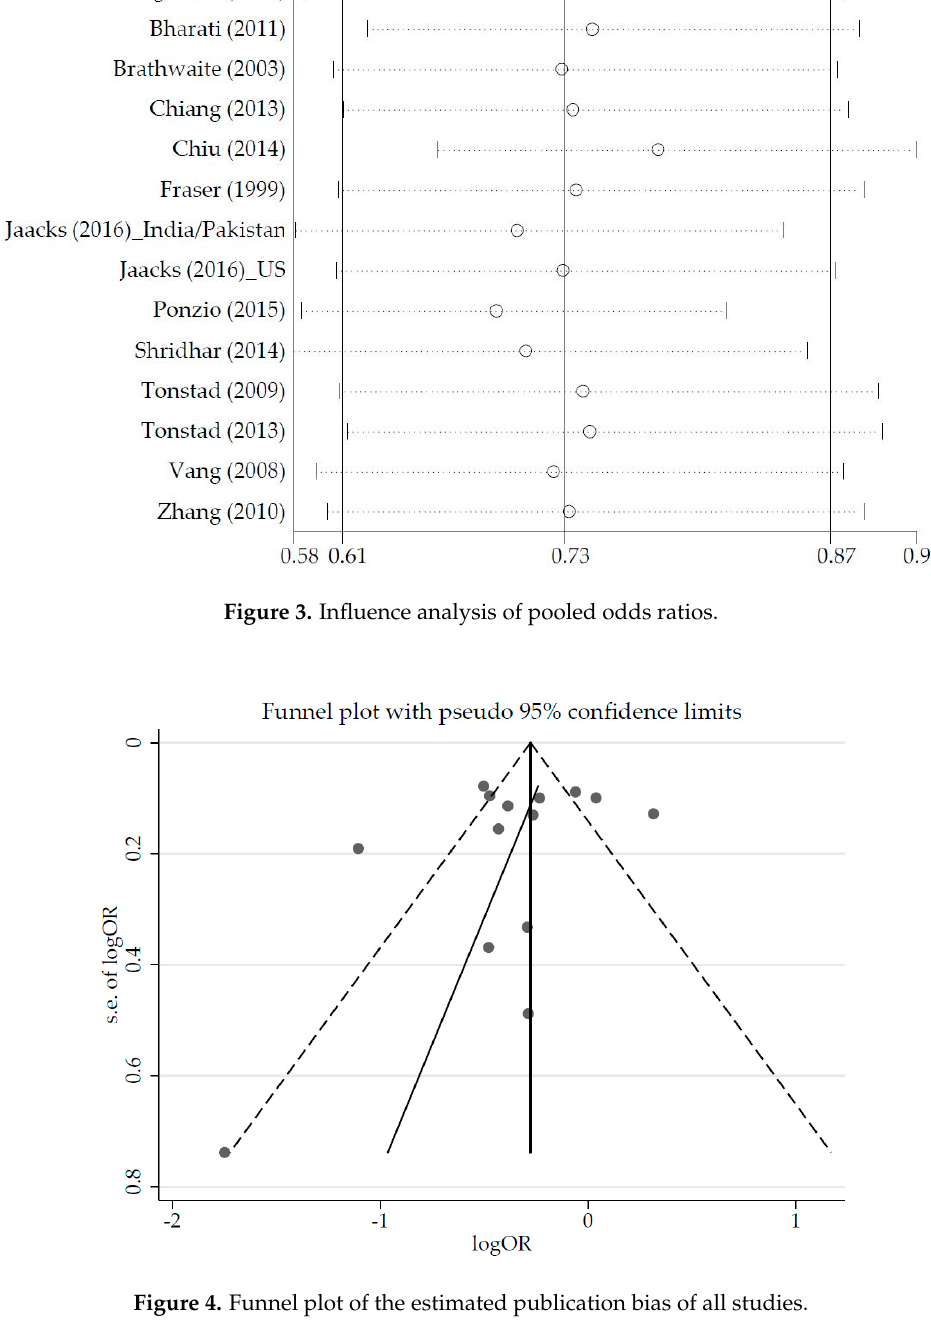
Figure 4. Funnel plot of the estimated publication bias of all studies.